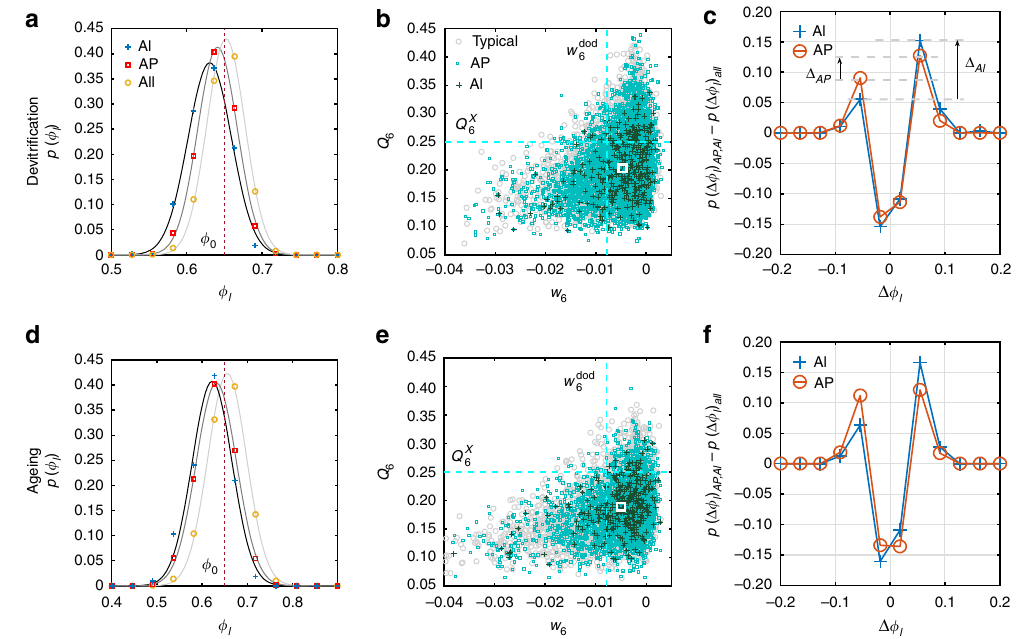
Figure 2 | Characterization of avalanche events. Averages are given over 50 events in both devitrifying and ageing events. ( a , d ) Distribution of local volume fraction f l before avalanche events. Both show a peak shift to lower f l for AIs, less so for APs. ( b , e ) w 6 and Q 6 distributions for AIs and APs (defined in text) overlaid on a typical distribution for all particles. The AIs especially are concentrated at lower BOO parameter values (both w 6 and Q 6 ). Dashed line Q X and w dod show the threshold values separating particles with highly crystal-like order ( Q 6 Z Q X ) and those with high dodecagonal or 6 6 6 ) 26 . Note that crystals have Q 6 larger than 0.4 (see the Structural analysis section in the Methods for details). The white icosahedral-like order ( w 6 r w dod 6 thick open square represents the average values of w 6 and Q 6 for AIs. On average, thus, AIs possess neither significant crystalline order nor locally favoured structures. This indicates that AIs are particles localized in disordered regions. ( c , f ) Difference between the probabilities of D f l for AI or AP subsets and the distribution for the system as a whole. There is a bias towards larger change for both AIs and APs, but there is a skew to positive change for AIs which is not seen for APs. For both devitrification and ageing, APs almost equally gain or lose density, but AIs have a strong tendency to increase local